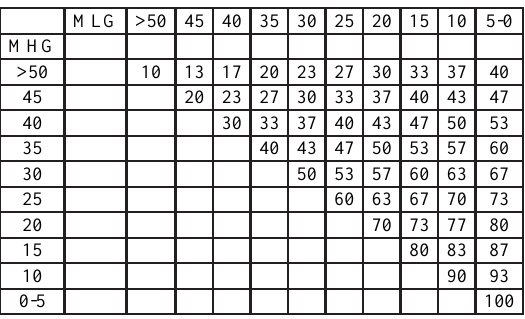
Table A4: Estimated removal efficiency (%) for combinations of mean highest and mean lowest groundwater levels (in cm below soil